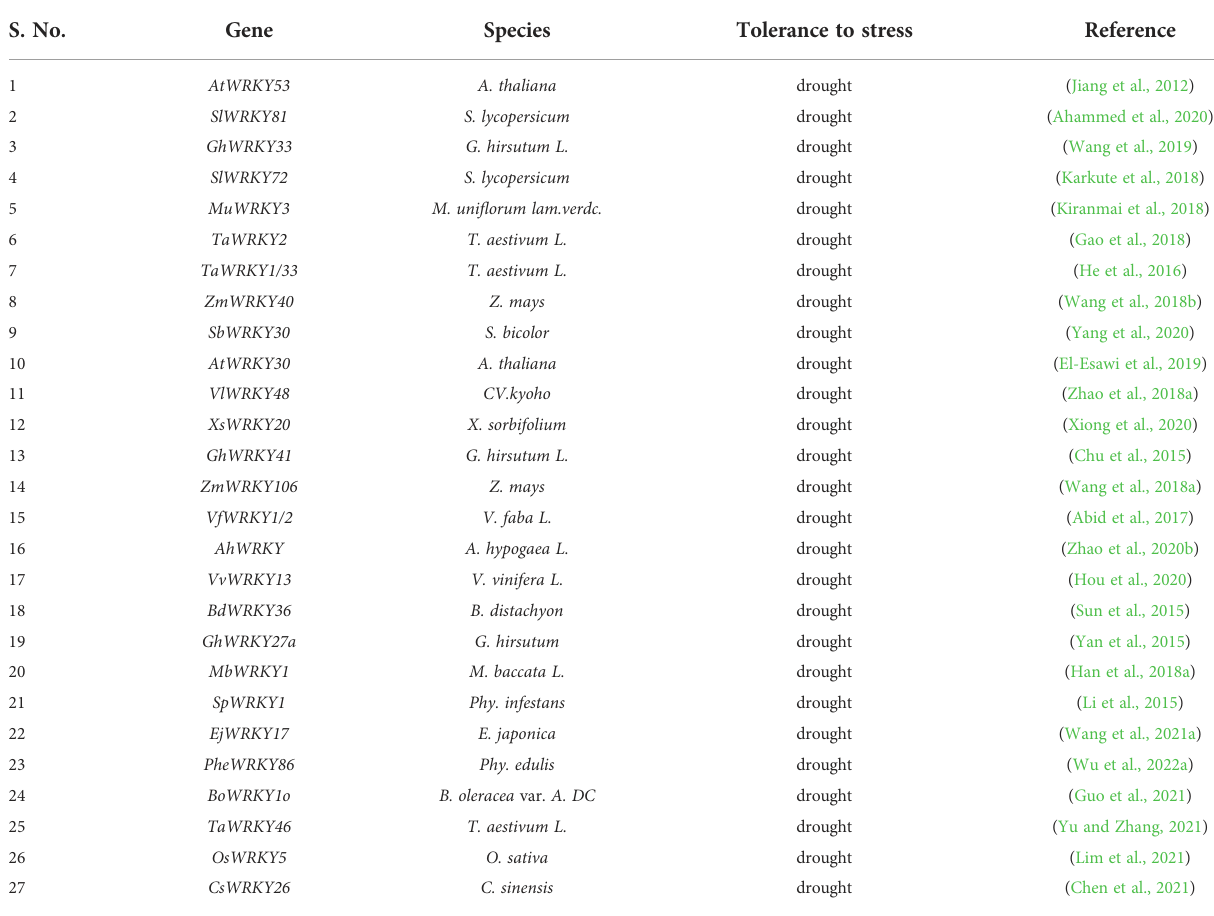
TABLE 2 Drought Stress-related WRKY TFs in